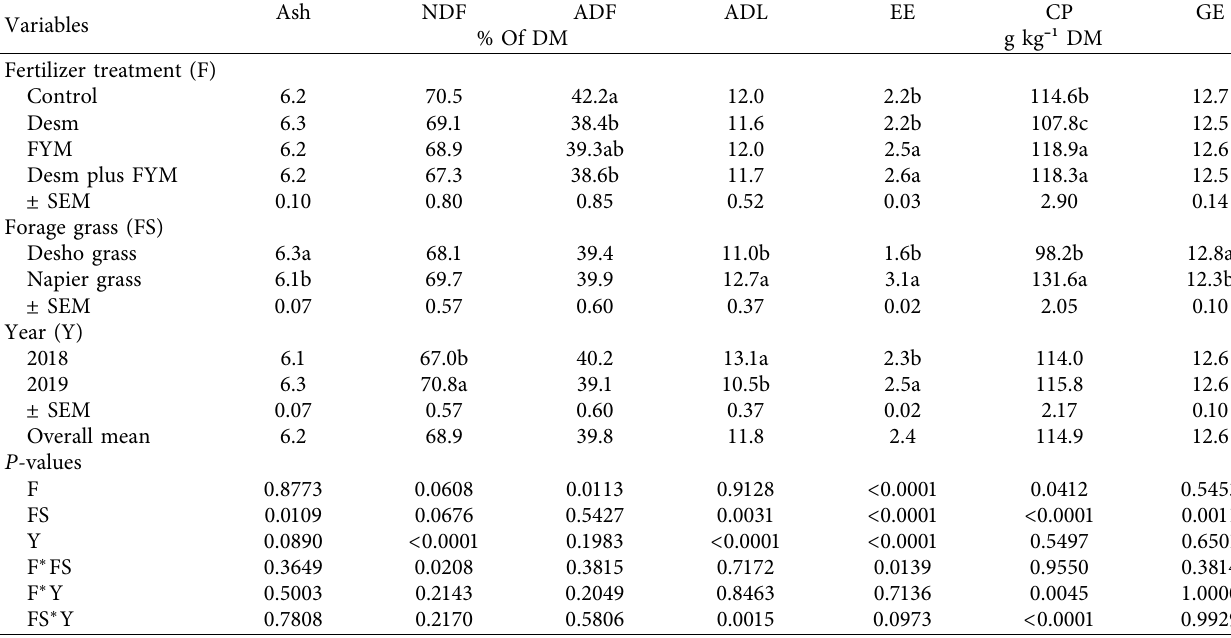
Table 2: Chemical composition of forage grasses cultivated using various fertilizer treatments at the Guder watershed. Variables Fertilizer treatment (F)